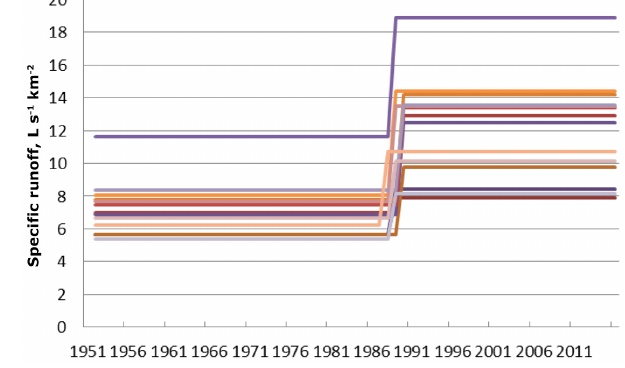
Figure 2. Regime shifts in winter (DJF) specific runoff of rivers in 14 stations where a statistically significant shift was detected in 1987/1988 or 1988/1989.